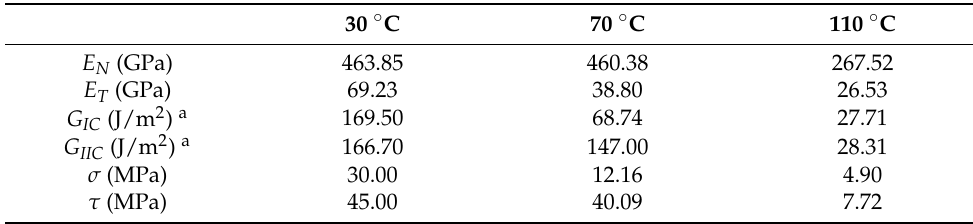
Table 4. Material properties of the cohesive